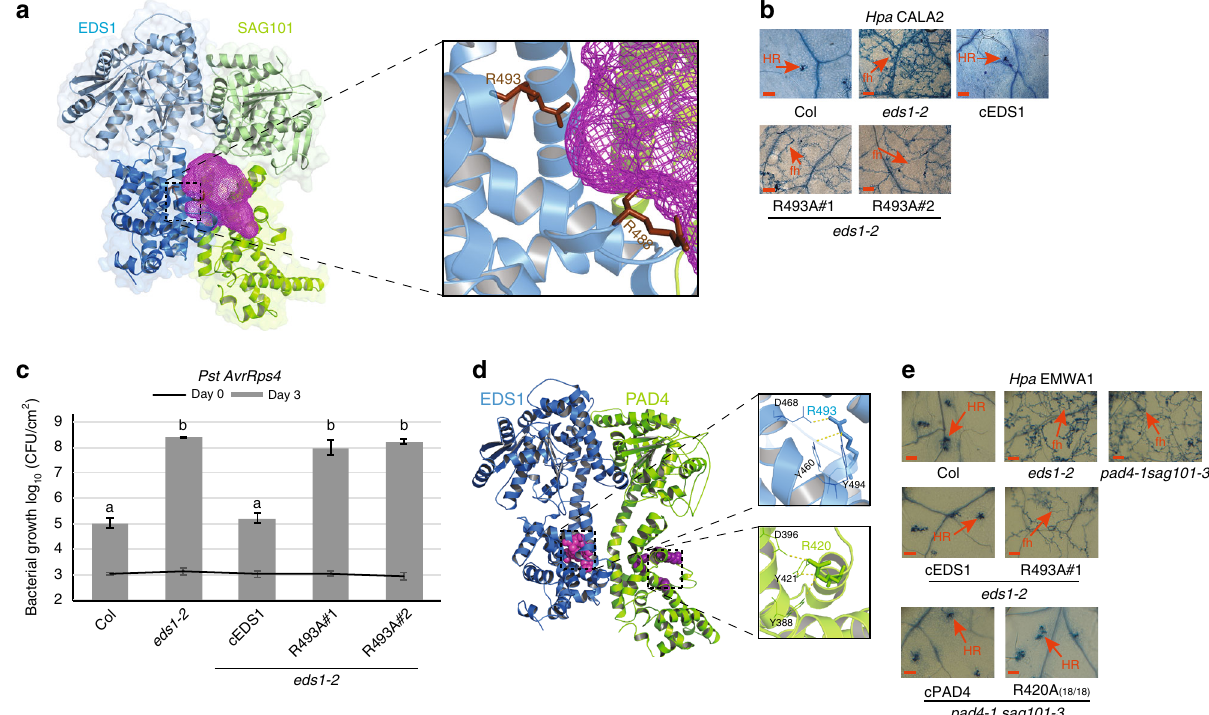
Fig. 1 Residues lining the EDS1 heterodimer cavity mediate immunity signalling. a Crystal structure of EDS1 (blue) – SAG101 (green) showing heterodimer formation chie fl y driven by the partner lipase-like domains (light tones) and producing a cavity (magenta mesh) formed by the EP-domains. In the zoom- out, two conserved EDS1 arginine residues lining the cavity are depicted as sticks (brown). b RPP2 resistance phenotypes of 2-week-old control and transgenic lines expressing YFP-cEDS1 or R493A. Hpa EMWA1 infected leaves were stained with trypan blue at 5 dpi. Scale bar represents 100 μ m. Images are representative of 24 leaves from two independent experiments. HR, hypersensitive response; fh, pathogen free hyphae. c . Four-week old Arabidopsis plants of the indicated genotypes were in fi ltrated with Pst AvrRps4 (OD 600 – 0.0005) and bacterial titres determined at 0 and 3 dpi. Bars represent mean of four biological replicates± SE. Differences between genotypes were determined using ANOVA (Tukey ’ s HSD, p < 0.005). Similar results were obtained in three independent experiments. d Homology model of EDS1 (blue) – PAD4 (green). Conserved residues in the EP-domains of EDS1 (magenta) and PAD4 (purple) are represented as spheres. EDS1 residues line the heterodimer cavity while PAD4 residues are not part of the cavity. A zoom-out of the sphere- represented residues shows ionic and hydrogen bonds formed by EDS1 R493 and equivalent arginine in PAD4 R420 with neighbouring residues. e RPP4 resistance phenotypes of 2-week-old control and homozygous transgenic lines expressing wild-type EDS1, PAD4 and mutated arginine variants. Hpa EMWA1 infected leaves were stained with trypan blue at 5 dpi. Scale bar represents 100 μ m. The PAD4 R420A image is representative of 18